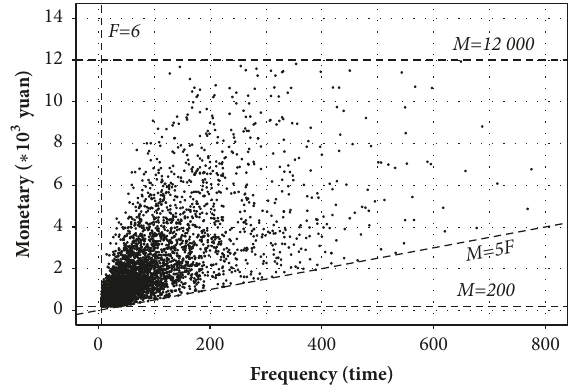
Figure 3: Scatter plot of “Frequency-Monetary” (sampling data).